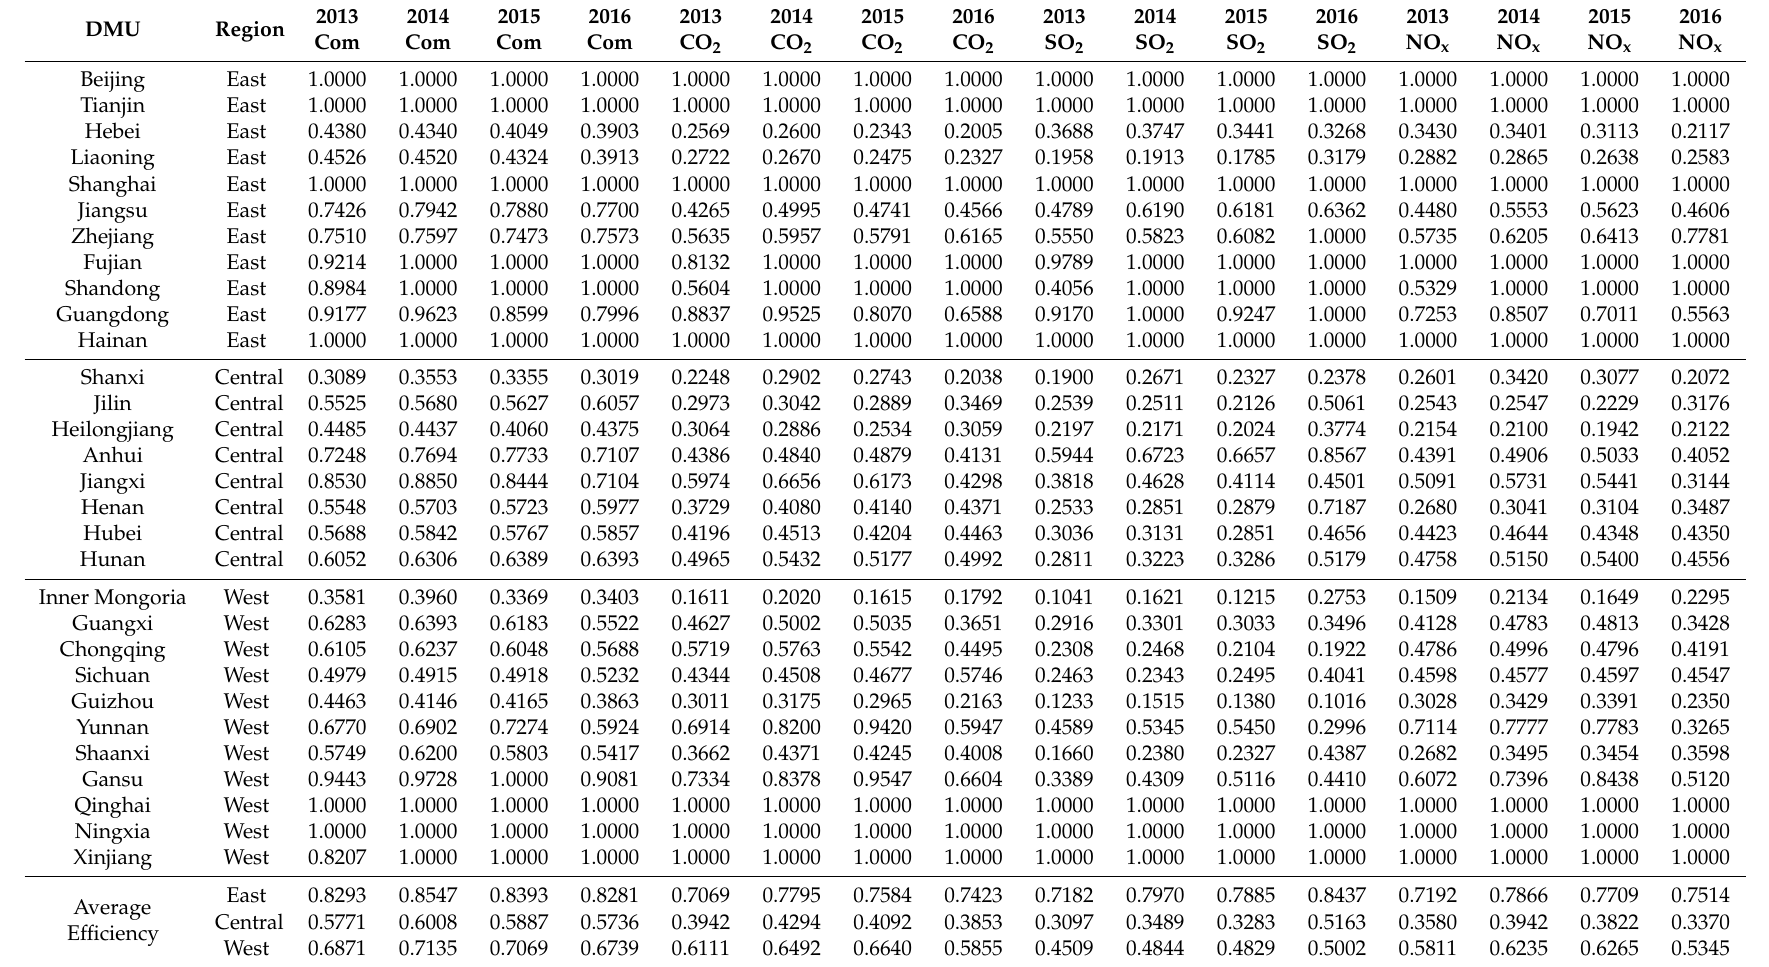
Table 6. Annual energy consumption, CO 2 , SO 2 , and NO x e ffi